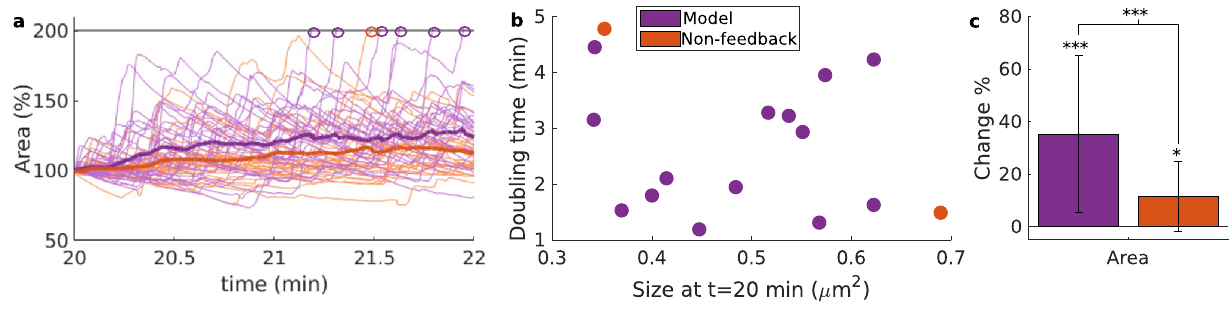
Figure 8. Spine size evolution upon LTP for different models. ( a ) Evolution of spine area changes. Circles mark the time point at which the spines double their area from that at minute 20, when there is an increase in the nucleation rate. The simulations corresponding to the model without feedback are color-coded in orange, whilst the simulations of the feedback-containing model are purple. ( b ) Time to doubling the spine area at minute 20. ( c ) Mean ± std of the percentage change of the area averaged over time. Time averages were taken 5 min before and after the change in nucleation rate. Asterisks: significance according to a Welsh’s test: *p-value = 0.05; 0.01 ***p-value < =